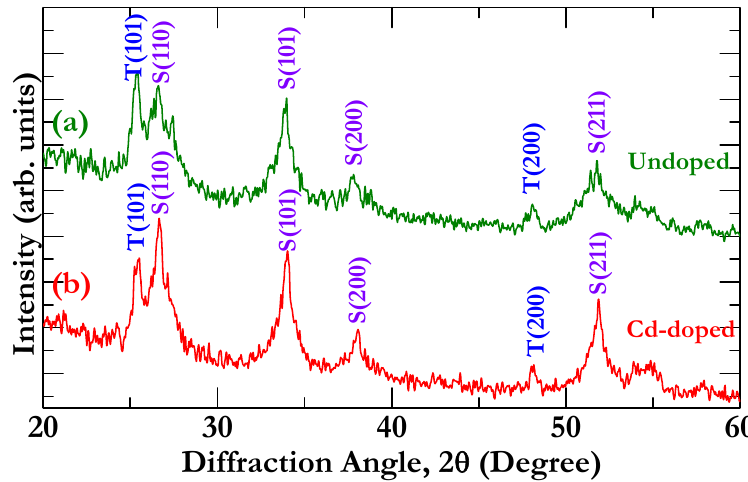
and the S represents SnO 2